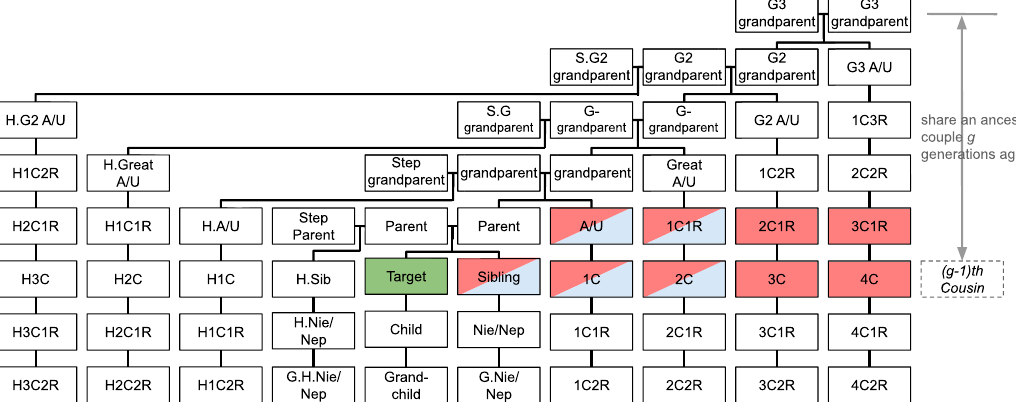
Figure 2. The familial relationships considered in the interdependent privacy model. We aim to uncover relatives of a targeted individual (shaded in green). 1C: first cousin; 1C1R: first cousin once removed, and so forth. Relationships shaded in blue are considered relevant when searching for relatives, while relationships shaded in red are considered when attempting to identify the